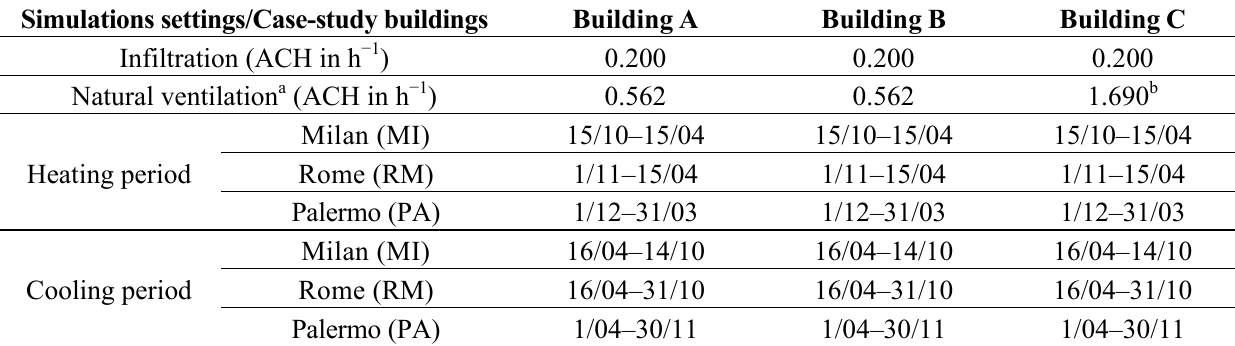
Table 6. TRNSYS simulations settings. ACH: the air changes per